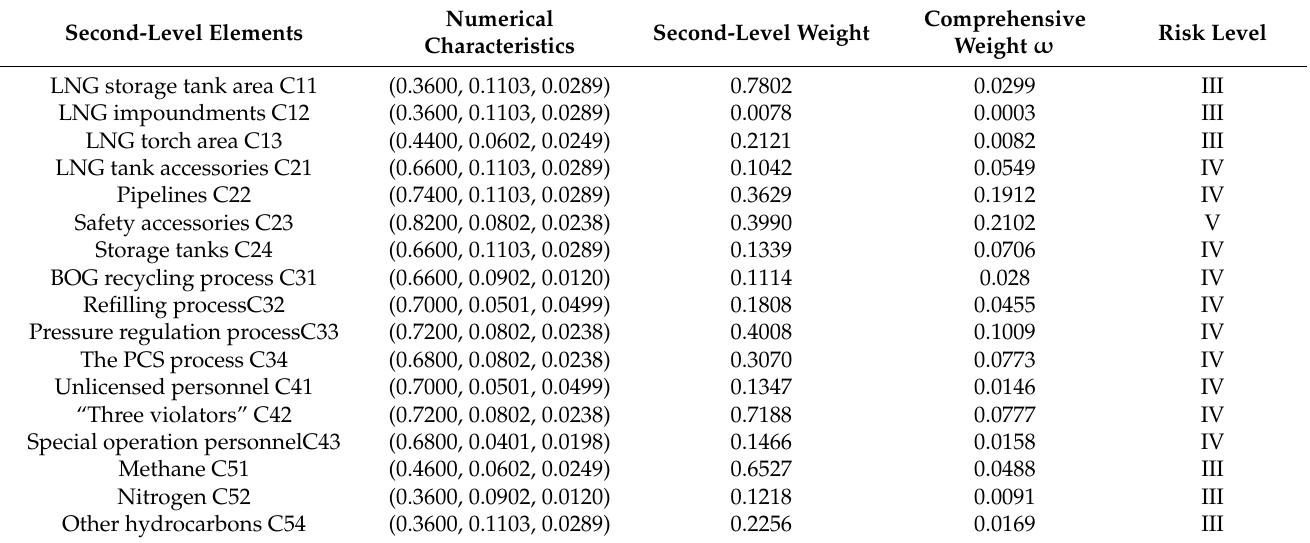
Table 8. Risk level of secondary risk